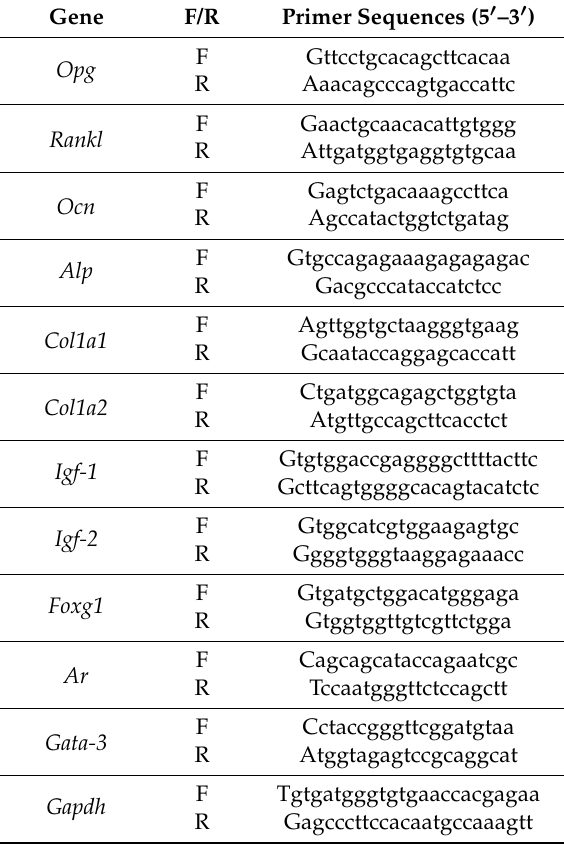
Table 1. Primers used for real-time PCR